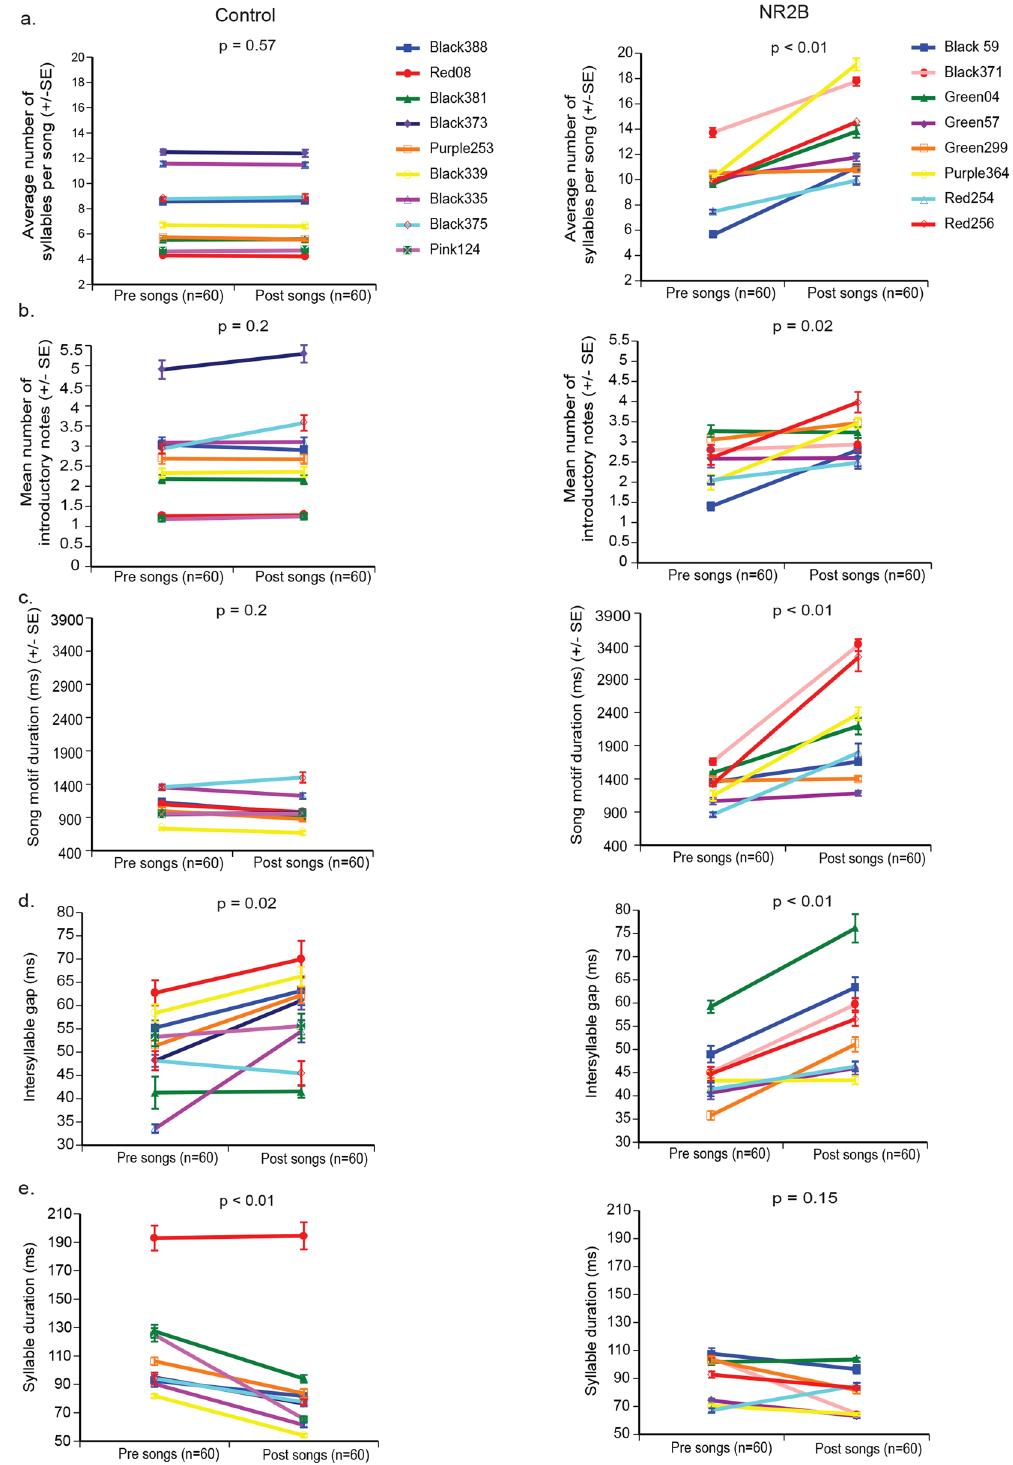
Figure 5. Overexpression of human NR2B induced changes in song motif structure. ( a ) Average number of syllables per song motif. ( b ) Mean number of introductory notes per song motif. ( c ) Song motif duration. ( d ) Intersyllable gap durations. ( e ) Average of all syllable durations (bird Red08 of the control group appeared to be an outlier, which was confirmed by a Dixon’s test in R in both presurgery (p = 0.02) and postsurgery (p < 0.0001) conditions, and thus not included in the statistical analyses of the entire group. Each line is one animal presurgery and postsurgery, mean ± SE, with p values determined using paired Wilcoxon signed-rank